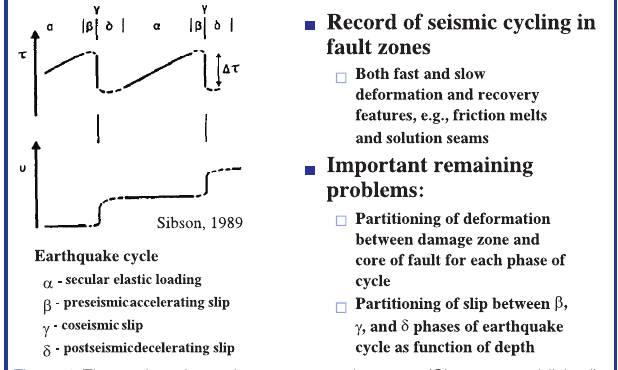
Figure 1. The earthquake cycle as a structural process (Chester, unpublished).